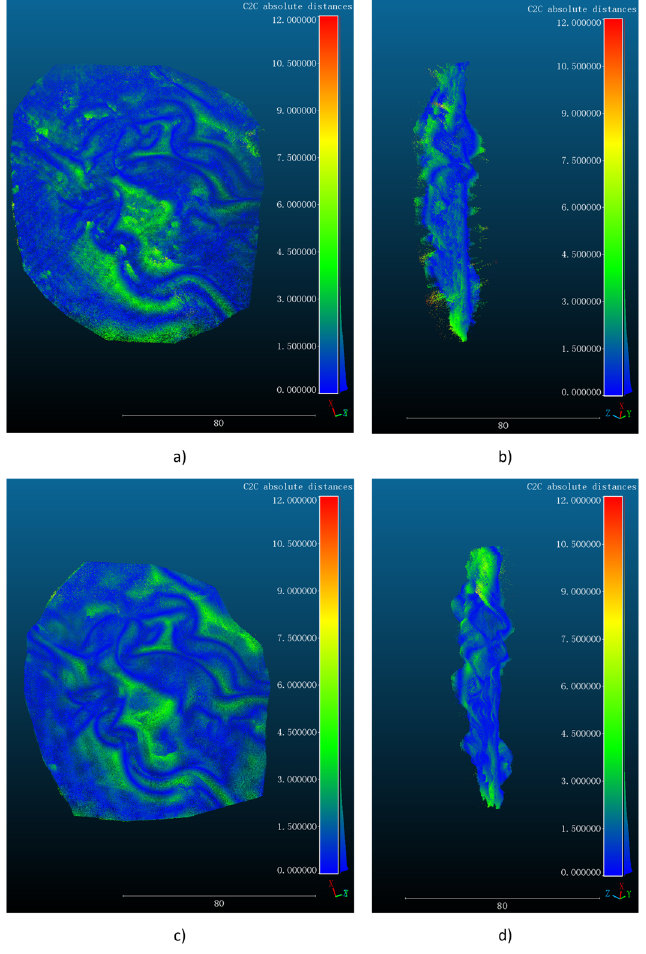
Figure 7. ( a ) Top view of cloud map registered by SGBM. ( b ) Side view of cloud map registered by SGBM. ( c ) Top view of cloud map registered by StereoNet. ( d ) Side view of cloud map registered by StereoNet.